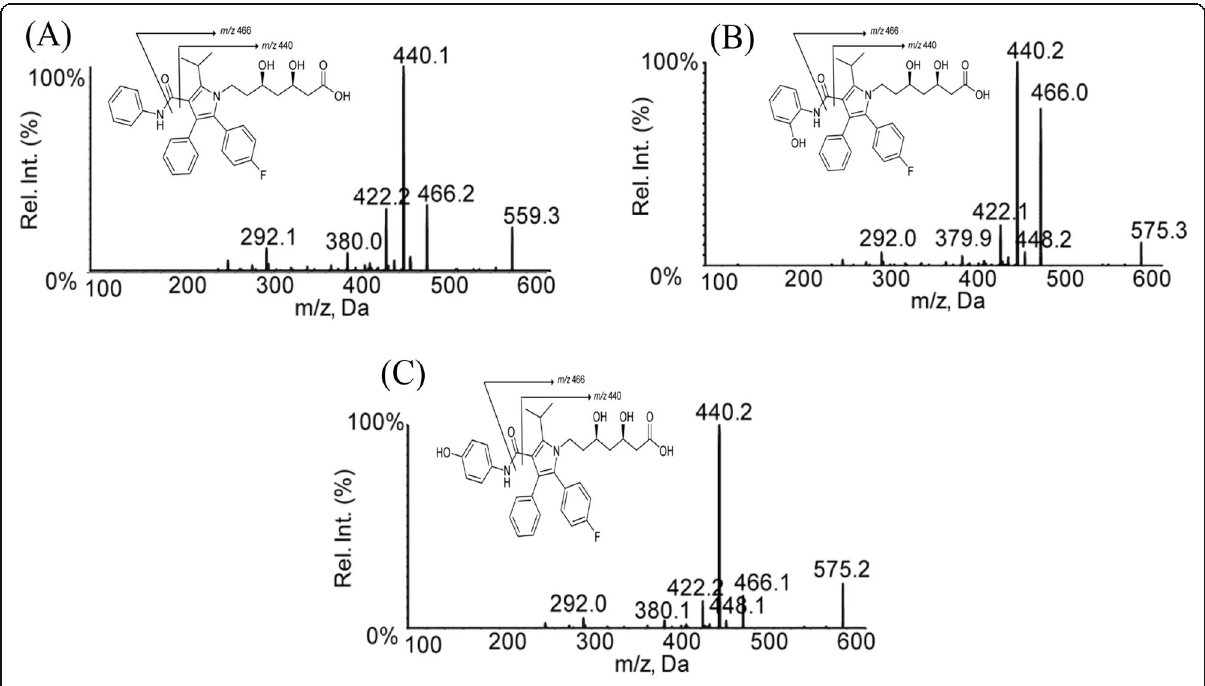
Fig. 2 Product ion spectra of a AT, b o-OH AT, and c p-OH AT in ESI + mode